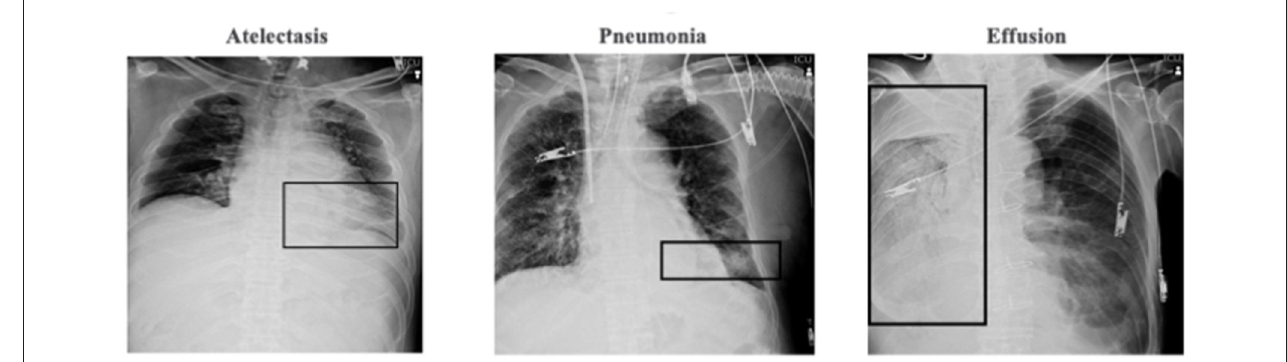
FIGURE 1 | NIH repository test image sample.